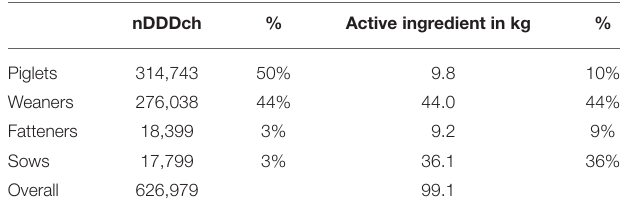
TABLE 1 | Total and relative (%) distribution of antimicrobial consumption within the different age categories (piglets, weaners, fatteners, and sows)